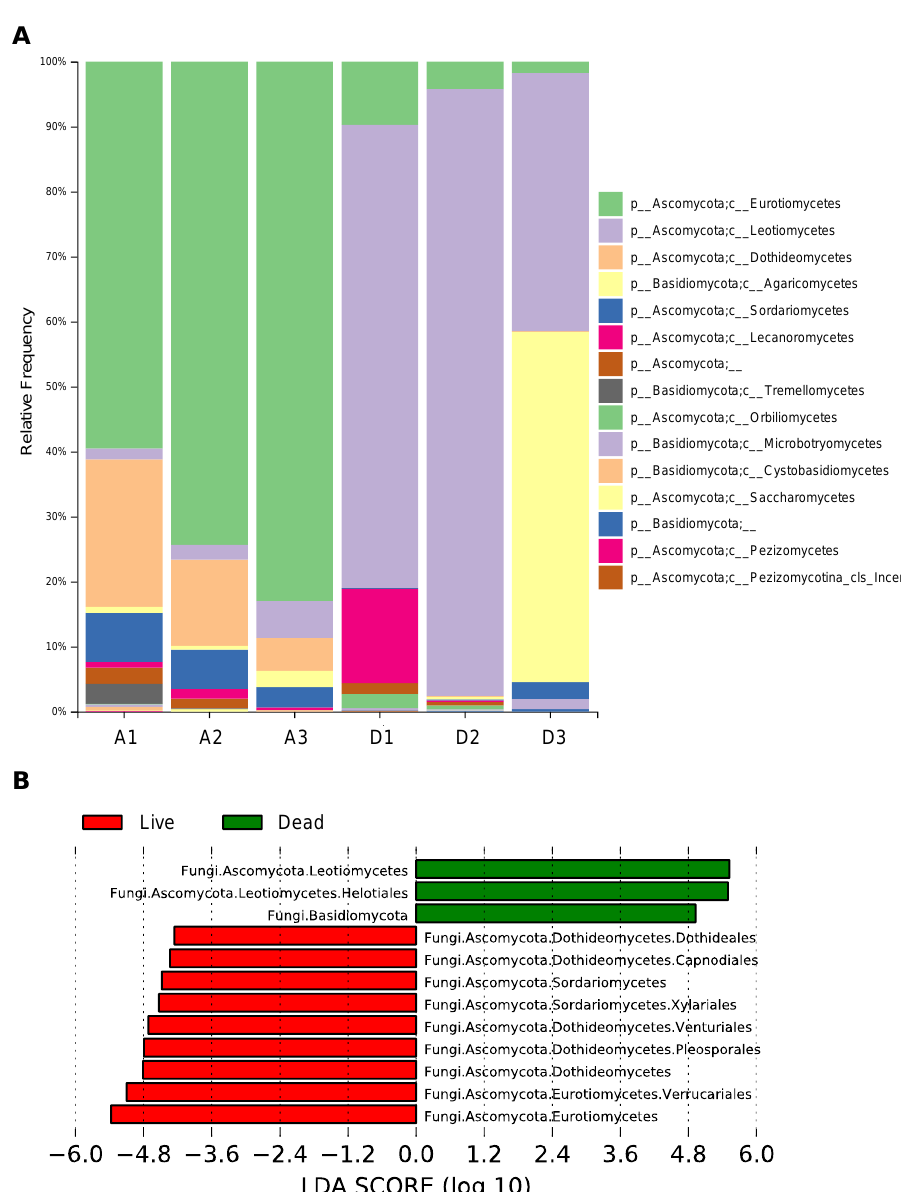
Figure 5. Abundance and taxonomic composition of the fungal communities from live and dead Korean fir trees. ( A ) Relative abundances of fungal taxa in live and dead trees. A1 to A3 indicate live tree and D1 to D3 indicate dead tree. “ p__ ” indicates phylum and “ c__ ” indicates class. ( B ) Differentially abundant fungal taxa between live and dead trees. Differentially abundant fungal taxa were analyzed using LEfSe with a linear discriminant analysis (LDA) score > 2.0 and a p < 0.05.